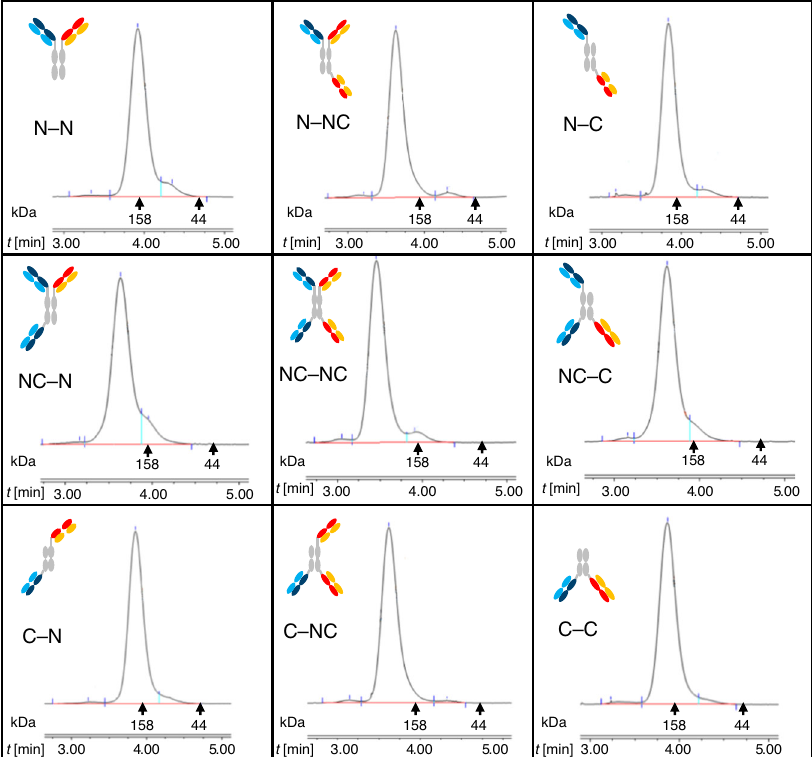
Fig. 5 SEC analyses con fi rm homogeneity and purity of bsAb products. N – N, NC – N, C-N, N – NC, NC – NC, C – NC, N – C, NC – C, and C – C are the different formats generated via FORCE (see Fig. 1b). Elution time of molecular weight standard markers (gamma globulin for 158 kDa, ovalbumin for 44 kDa) is indicated by arrows. Y-axes showing mAU are omitted for clarity (comparable signals and thus yields were obtained for all assembly reactions). Homogeneity of bispeci fi c products (% monomer peak SEC) is: 92% for N – N, 96% for N – NC, 94% for N – C, 87% for NC – N, 92% for NC – NC, 91% for NC – C, 95% for C – N, 97% for C – NC and 96% for C – C. In general, the homogeneities we saw across a large number of bsAb products is suitable for bispeci fi c screening approaches. MS veri fi cation is not a standard analytical package for all assembled molecules, but during method development all formats have been veri fi ed by MS. Educts (input molecules) were characterized by SEC, capillary-electrophoresis and MS (Supplementary Fig. 1). Source data are provided as a Source Data fi